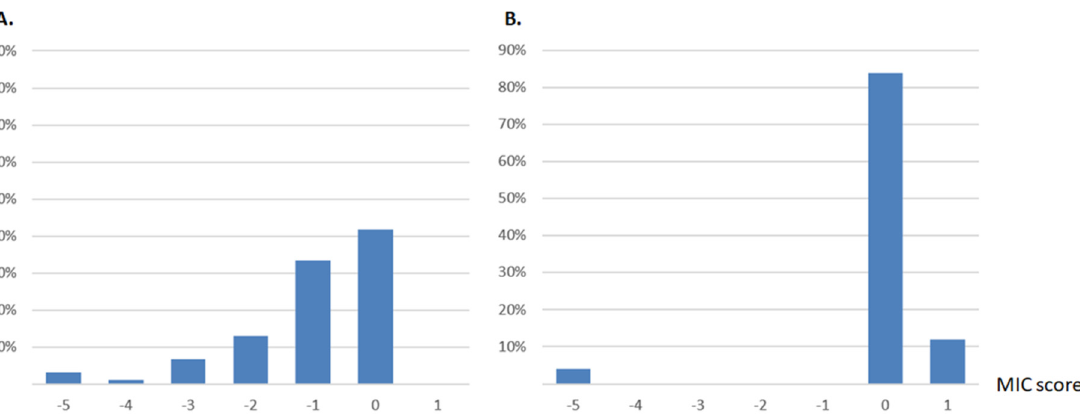
Figure 1. ( A ) Effects of mutations on MIC score when changing TEM-1 residue with that of CTX-M-15 ( n = 236, dataset from Firnberg et al. [8]). ( B ) Effects of mutations on MIC score when changing CTX-M-15 residue with that of TEM-1 ( n = 25). MIC score corresponds to log 2 (MIC mutant /MIC WT ). For each collection, one single mutant harbored an inactivating mutation (MIC score = − 5): G251W in TEM-1, and W251G in